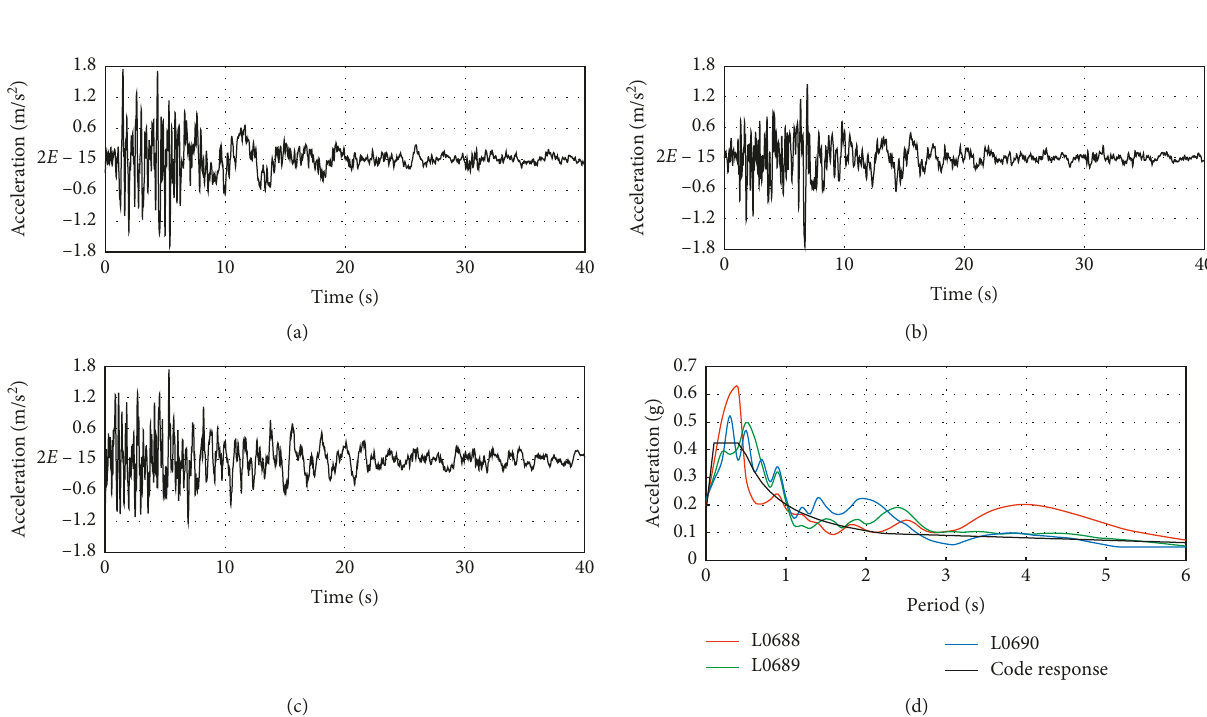
Figure 14: L0689 series accelerogram. Time history of acceleration in (a) secondary direction (L0688), (b) primary direction (L0689), and (c) vertical direction (L0690). (d) Response spectrums compared with the design spectrum in